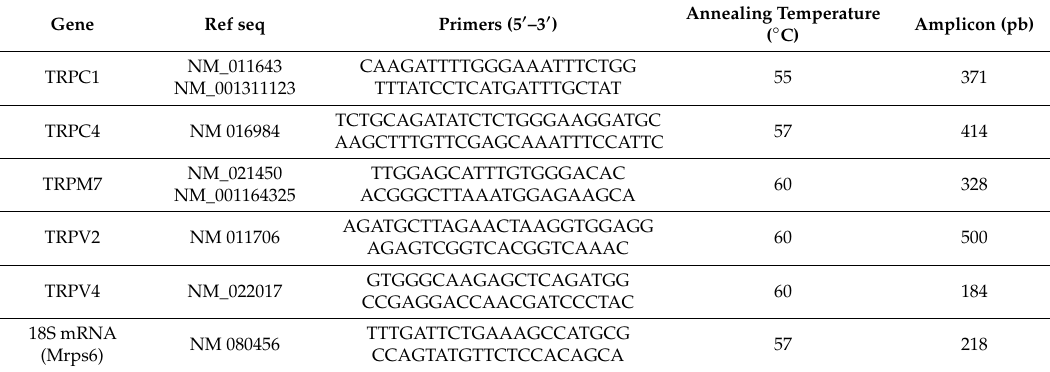
Table 1. Mouse gene-specific primers for